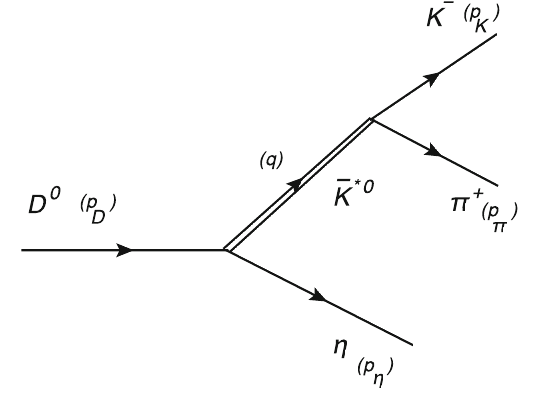
Fig. 6 Diagram for D 0 → ¯ K ∗ 0 η → K − π + η . The momenta of the particles are written in parenthesis and q ≡ p K + p